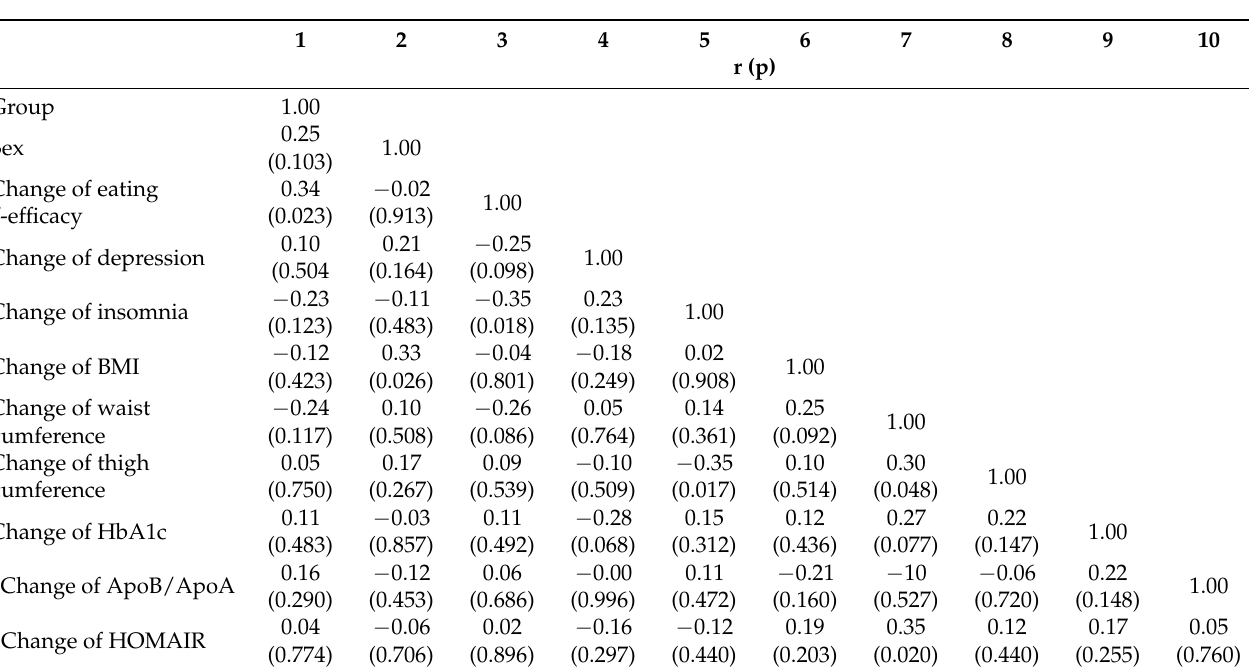
Table 4. Relationships between sex, group and differences of behavioral skill and health